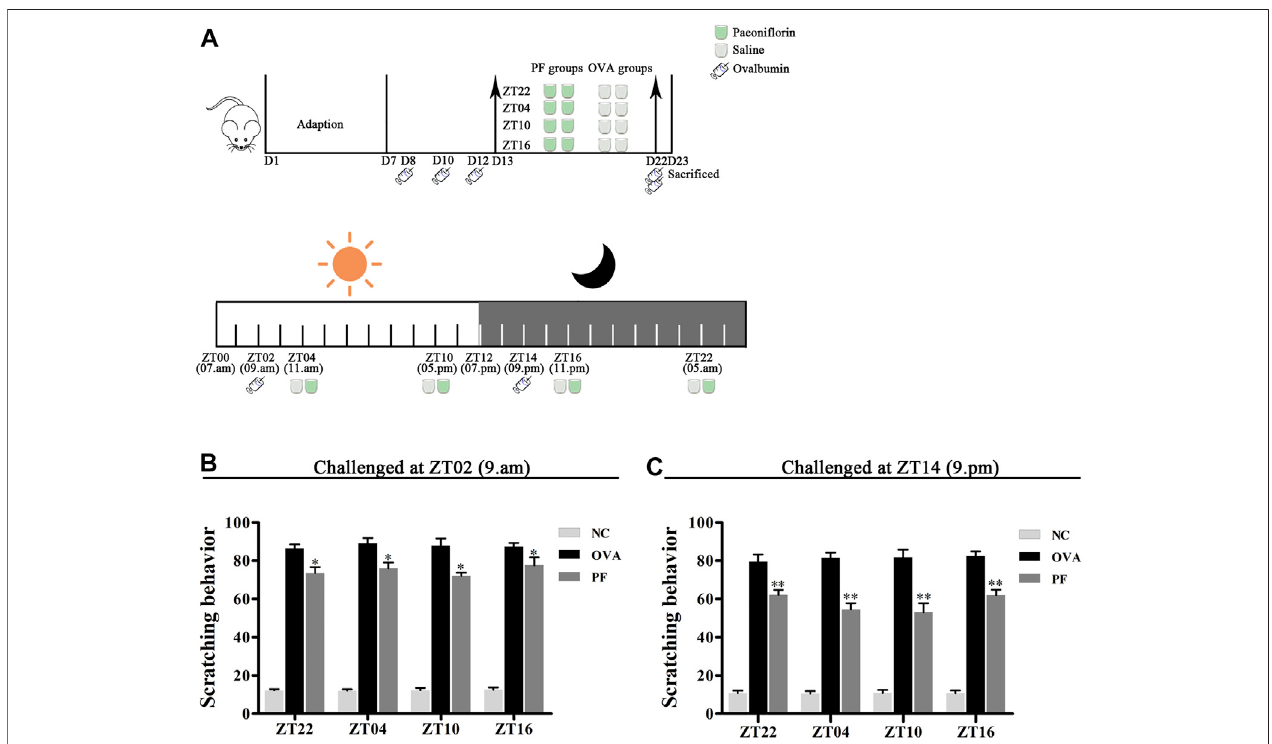
FIGURE1| Experimentaldesign (A) andEffectofPFtreatmentonscratchingfrequency (B,C) .144maleBALB/cmice(urticaria-likeanimals)wererandomlydivided into12groupsasfollowsmodeledatZT02orZT14 ( n (cid:1) 6ineachgroup): normal control(NC)groupstreatedwithsaline, including 1)NCZT22, 2)NCZT04, 3)NCZT10, and4)NCZT16;modelgroupsinjectedintraperitoneally(i.p.)withovalbumin(OVA)/aluminiumhydroxide,including5)OVA+salineZT22,6)OVA+salineZT04,7)OVA+ salineZT10,and8)OVA+salineZT16;andPFgroupsinducedwithOVA/aluminiumhydroxideandtreatedwith100 mg/kgperdayofpaeoni fl orin(PF),including9) OVA + PF ZT22, 10) OVA + PF ZT04, 11) OVA + PF ZT10, and 12) OVA + PF ZT16. To induce urticaria-like lesions (UL), all mice except those in NC groups were sensitizedi.p.with1 mlofaluminiumhydroxidesolutioncontaining1 mgofOVAatZT02orZT14ondays8,10,and 12,and theywerechallengedi.p.with2